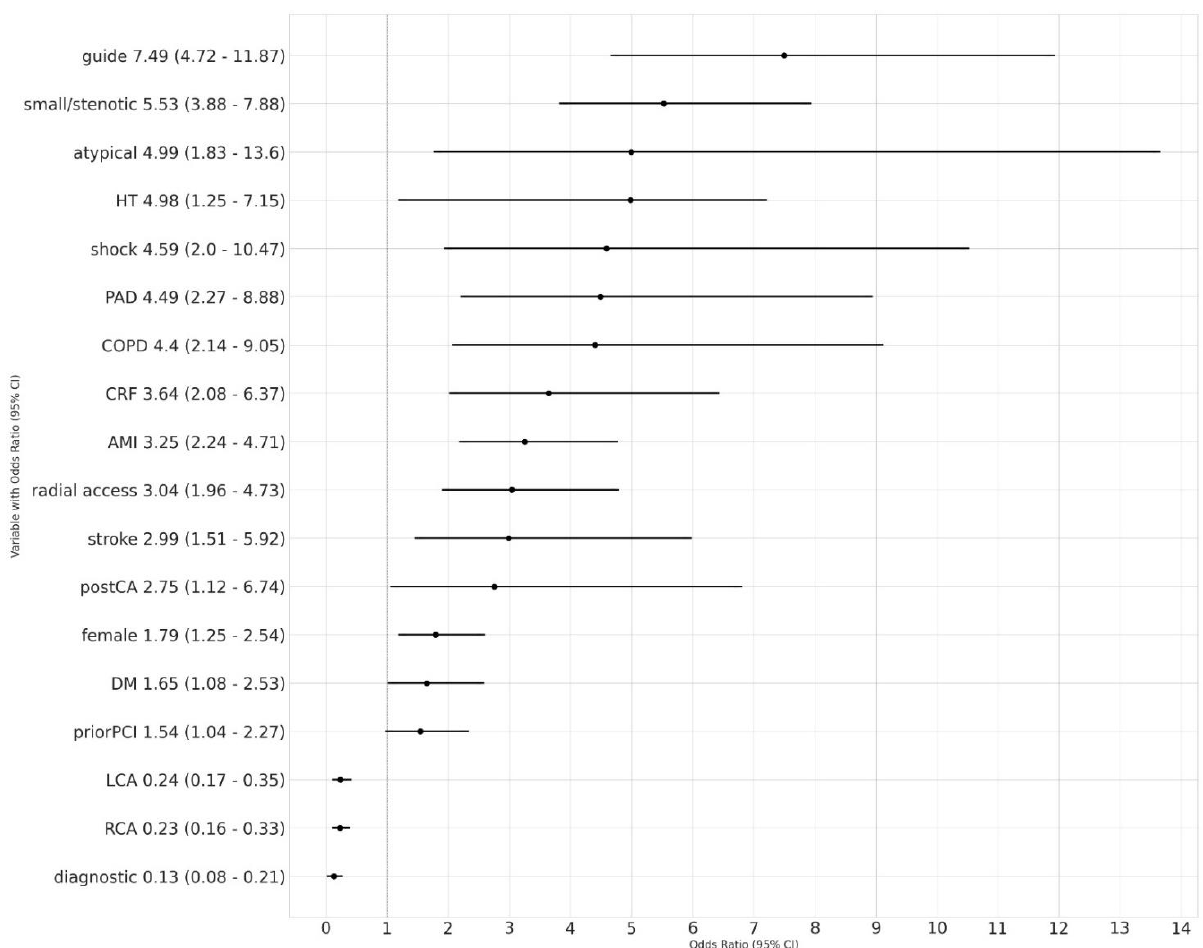
Figure 1. Multivariable logistic regression modelling of catheter-induced dissection predictors. Adjusted OR (point estimate) and 95% CI (error bars) indicate the likelihood ratio of dissection from the logistic regression. OR > 1 indicates increased odds of dissection. CI: confidence interval; OR: odds ratio. AMI: acute myocardial infarction; atypical: atypical origin of coronary artery; CA: